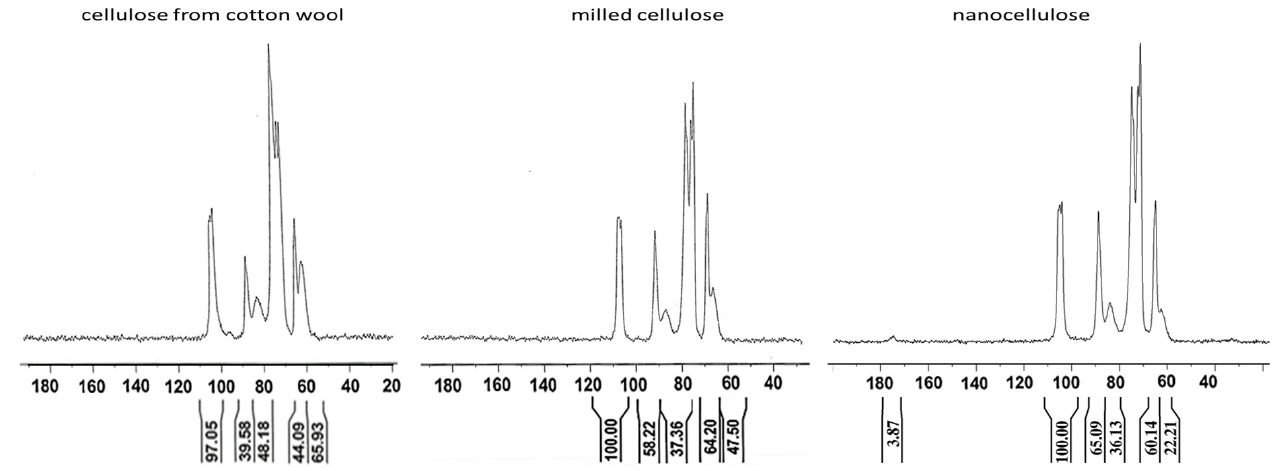
Figure 7. 13 C CP-MAS NMR spectra of cellulose from cotton wool, milled cellulose and nanocellu- lose (ONC). Table 3. Integral % values with respect to anomeric signals from 1 3 C NMR spectra.